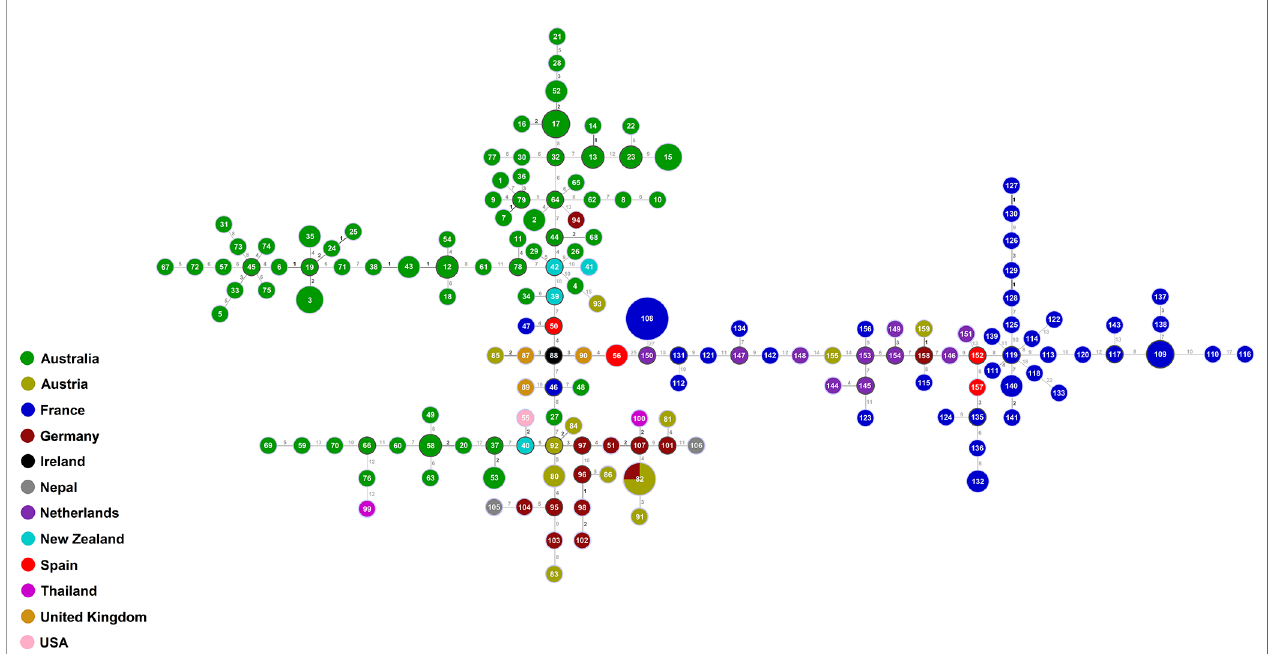
FIGURE 3 | goeBURST minimum spanning tree for all 159 sequence types obtained from the combination of all allele types of the six MLST loci ( ACT , CAL, EF1 a , RPB2 , SOD2 and TUB ) using the PHYLOViZ 2.0 analysis software, indicating the genetic relationships between all Australian and non-Australian S. aurantiacum isolates studied.